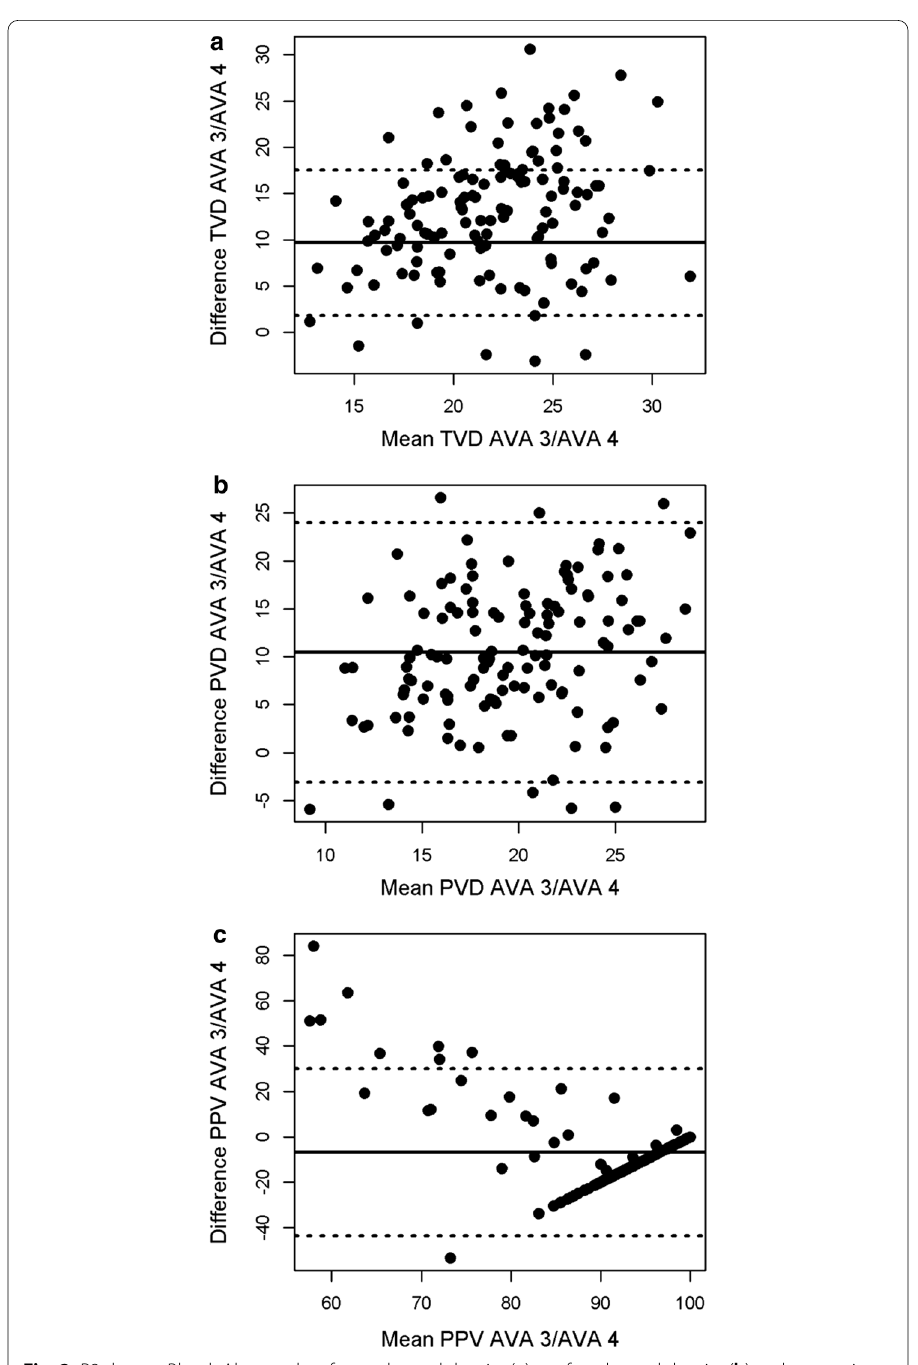
Fig. 2 P2 dataset Bland–Altman plots for total vessel density ( a ), perfused vessel density ( b ) and proportion of perfused vessels ( c ). The x -axis shows the mean of the two measurement methods and the y -axis shows their difference. The mean difference is represented by the solid line and the dashed lines represent the limits of agreement, equivalent to 1.96 SD of mean ±